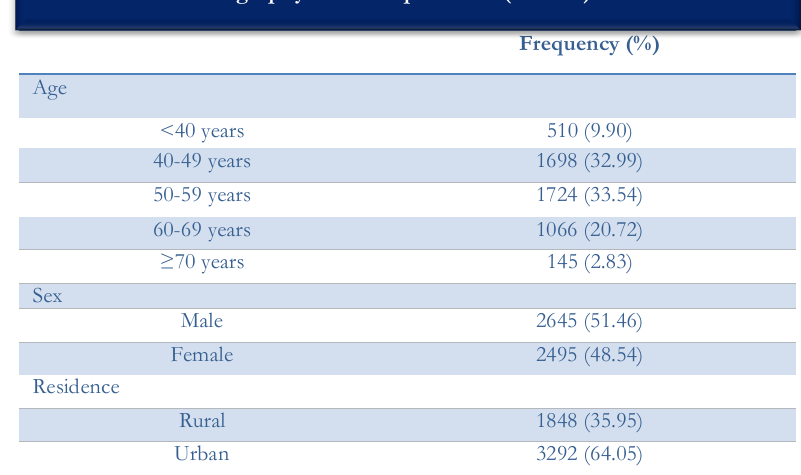
Table 1: Socio demography of the respondents (n=5140)